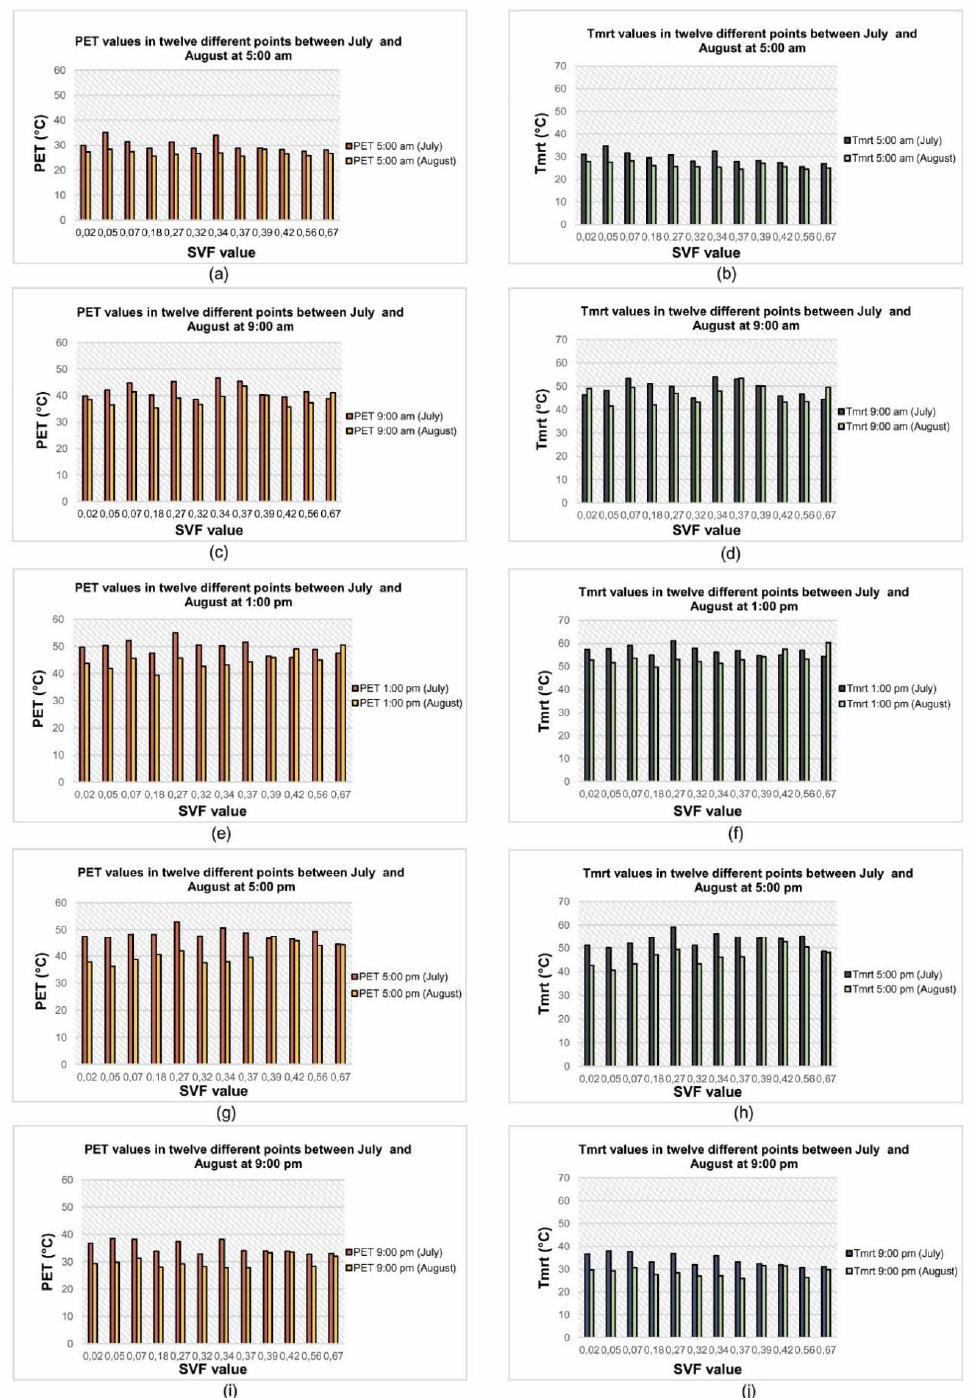
Figure 5. Assessment of PET and Tmrt levels in 12 studied points during July and August 2018 at 5:00 a.m., 9:00 a.m., 1:00 p.m., 5:00 p.m., and 9:00 p.m.: ( a , c , e , g , i ) are PET values; ( b , d , f , h , j ) are Tmrt values. A significant difference, between PET and Tmrt values in the second period (9:00 a.m., 1:00 p.m., 5:00 p.m.) (Figure 6) was found in July and August, relative likely to the elevation of air temperature